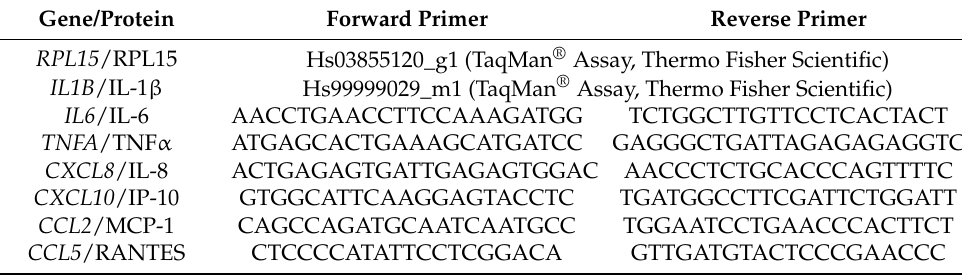
Table 1. Sequence of primer pairs employed for RT-qPCR